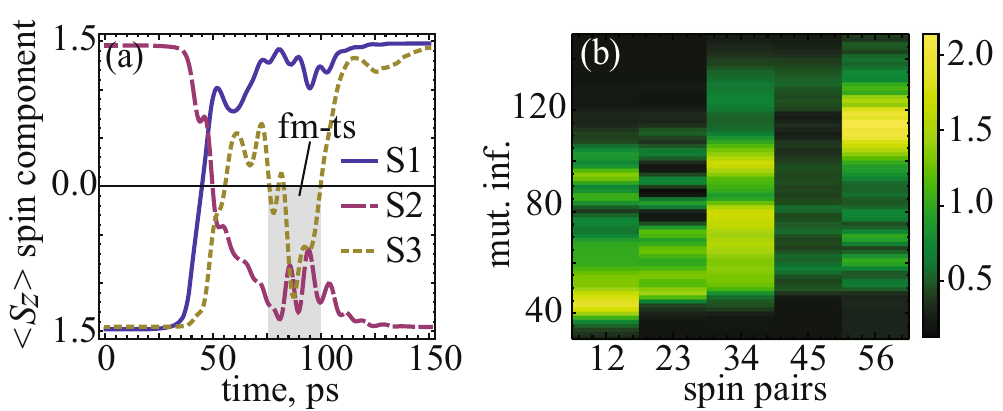
Figure 6. ( a ) Time evolution of < S z > spin components for S 1, S 2 and S 3 spins of 6-atomic chain. Inset: the transient ferromagnetic-like state (fm-ts) for a time ~25 ps is observed between S 2 and S 3 spins within the time range from ~75 ps to ~100 ps . Diagram ( b ): two-particle mutual information between neighboring spins in considered